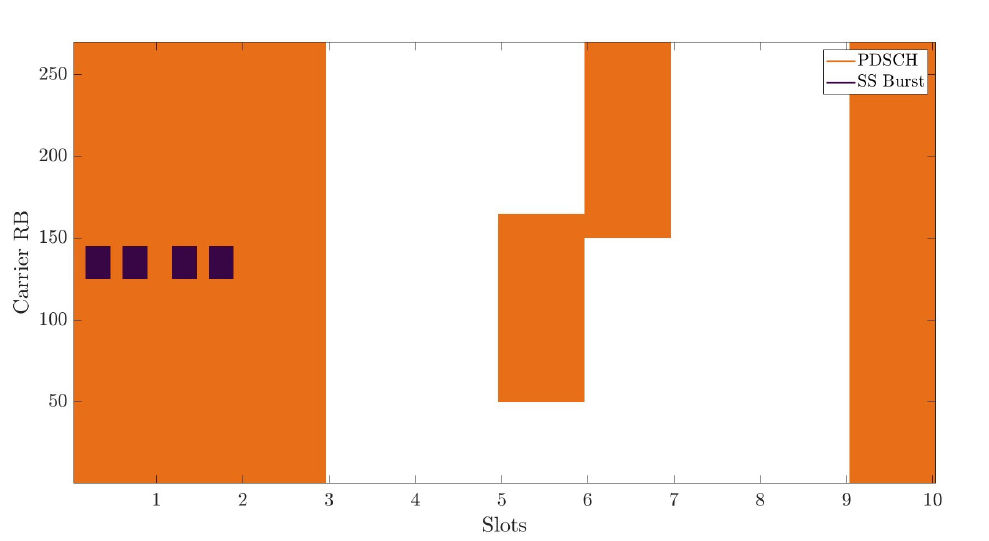
Figure 6. Resource grid partially allocated for data